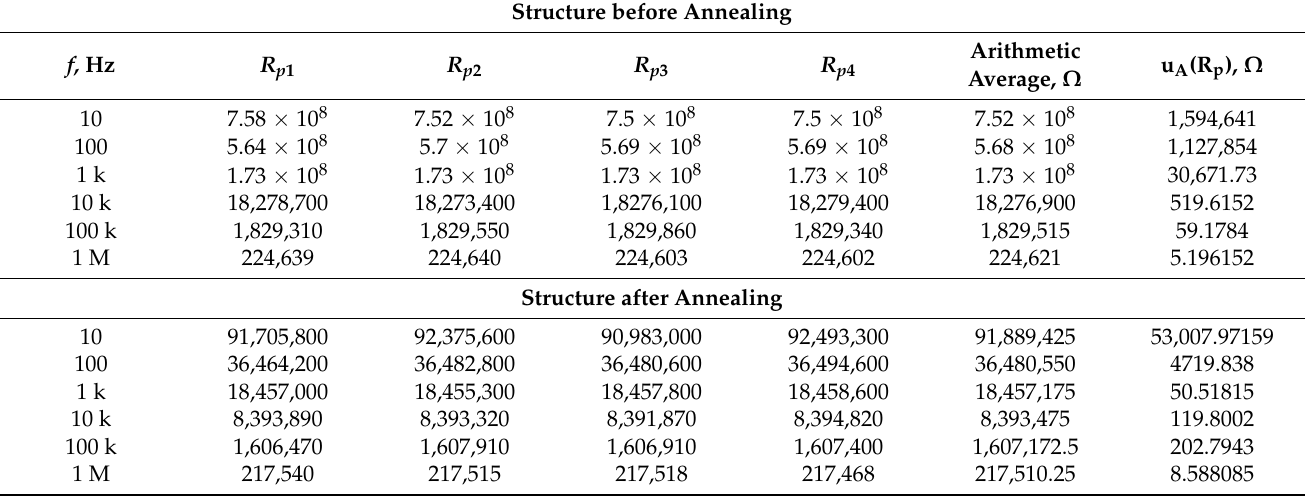
Table 1. List of measuring resistances and the value of the standard measurement uncertainty of type A